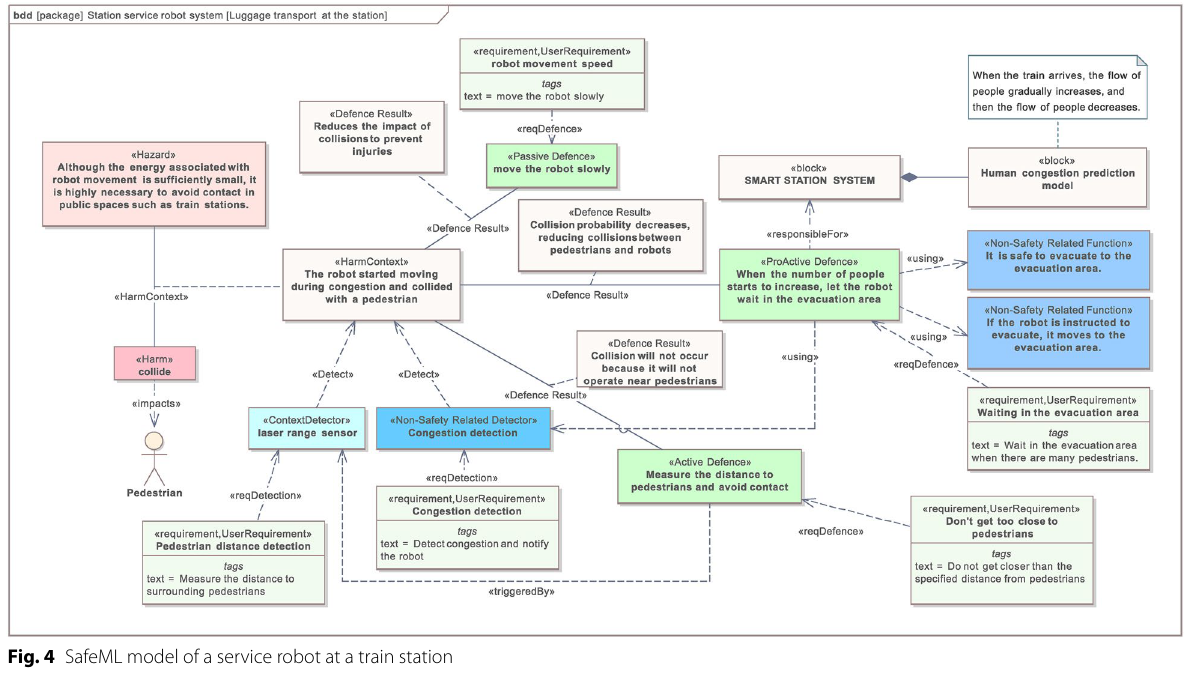
Fig. 4 SafeML model of a service robot at a train station